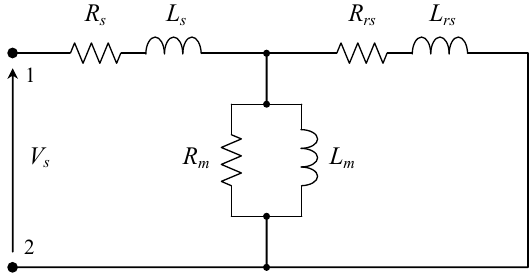
Figure 1. Basic per-phase equivalent circuit of the IM at a standstill.